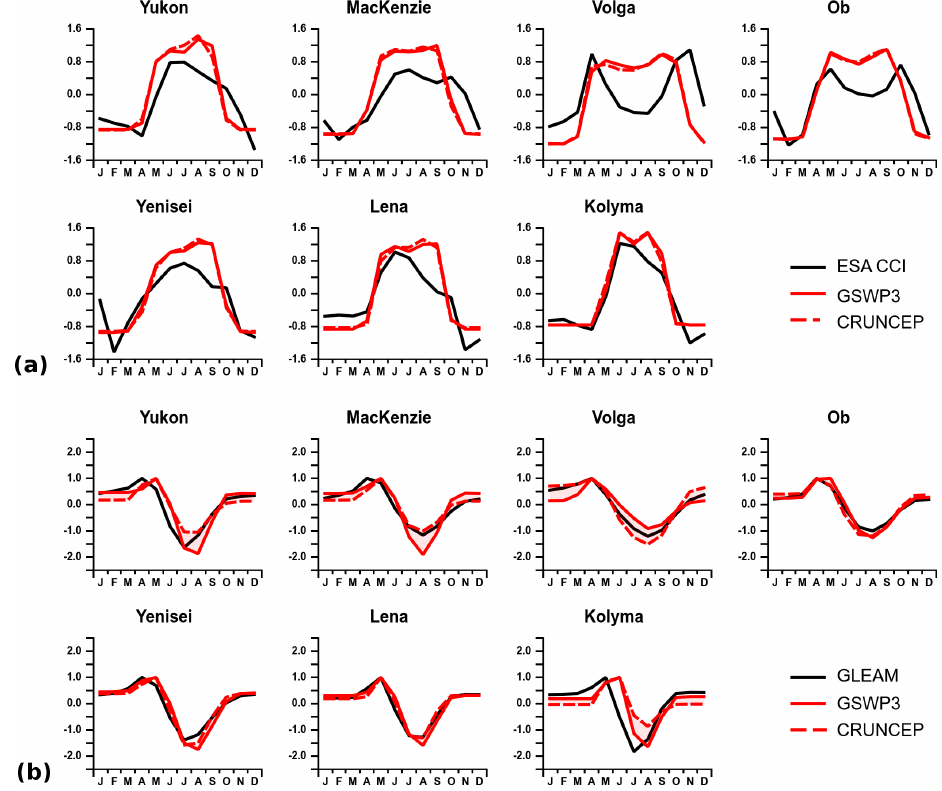
Figure 10. Monthly mean seasonal relative (a) topsoil (–) and (b) root soil moisture (–), both normalized by their multi-year SD, simulated with the GSWP3 and CRUNCEP forcings over the seven basins (see Fig. 2b), averaged over the period 1981–2007. The results are compared with (a) satellite-derived observations from ESA CCI and (b) the GLEAM data-driven model assimilated against satellite